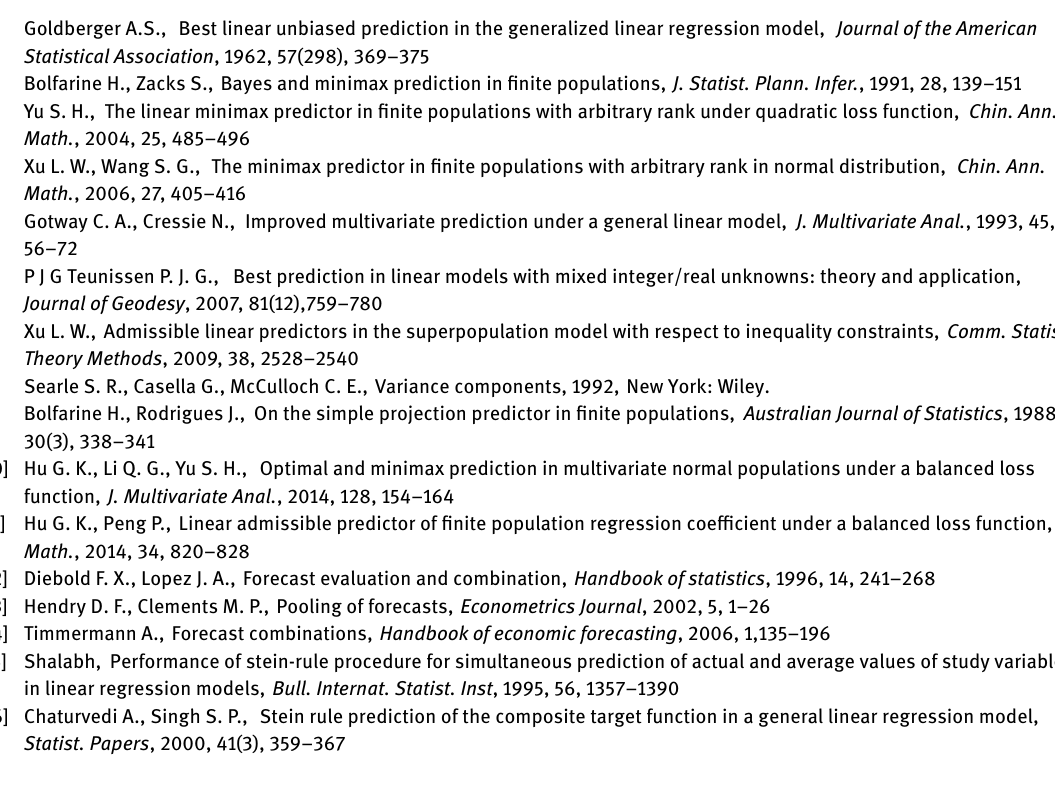
, ˆ δ (with different λ ) and ˆ y BLUP BLUP